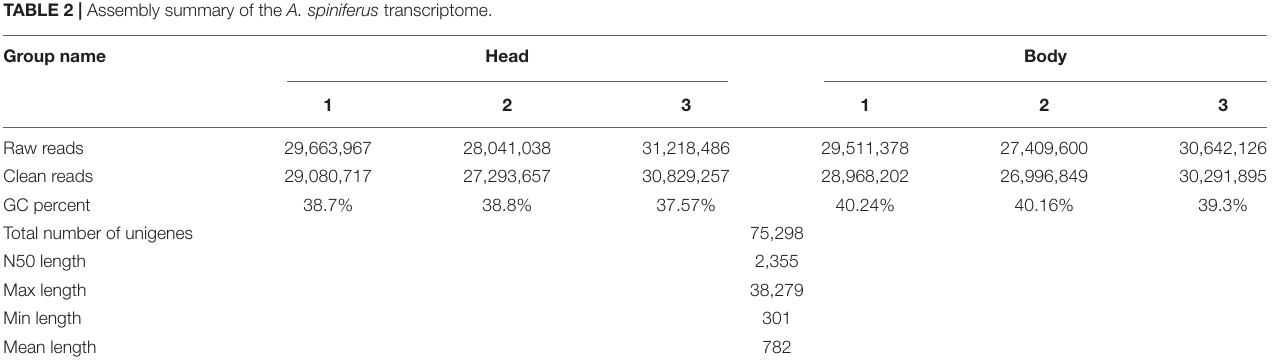
TABLE 2 | Assembly summary of the A. spiniferus